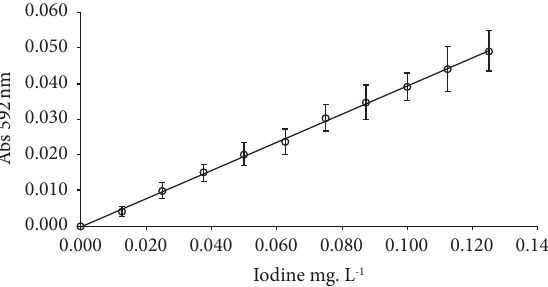
Figure 1: Adjusted analytical curve for iodine quantifcation in the water samples collected from locations in fve Brazilian macroregions. Table 2: Percentage of iodine based on the classifcation of iodine concentration in the water samples collected from Primary Healthcare Units (PHU) in locations situated in the macro regions of Brazil. Location/region